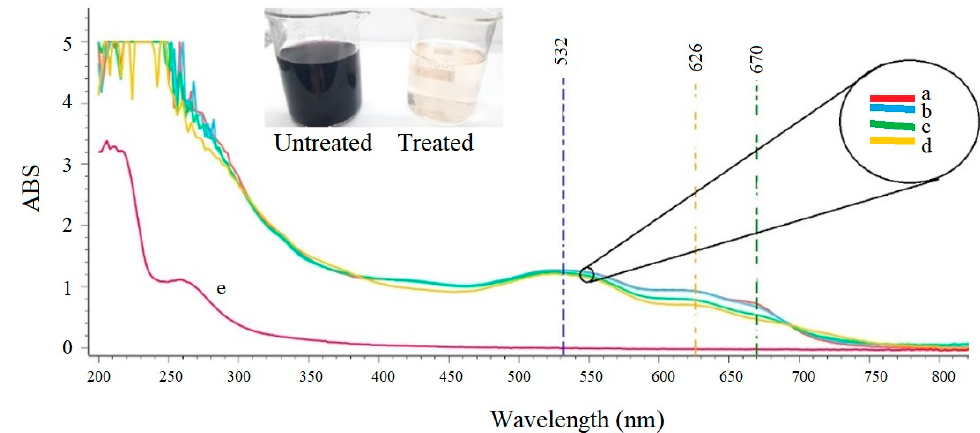
Figure 5. Absorption spectrum of the untreated textile wastewater at different pH’s: pH 9 ( a ), pH 6 ( b ), pH 4 ( c ) and pH 2 ( d ). Spectrum of textile wastewater treated with orange seed bio-adsorbent ( e ). Table 5. Comparison of the composition of crude textile wastewater (TW), bio-adsorbent treated TW, and microfiltration (3 µm) treated TW.